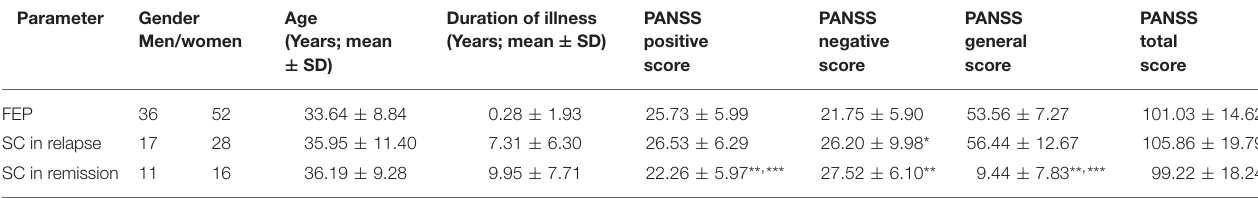
TABLE 1 | Demographic data and clinical disability measures.